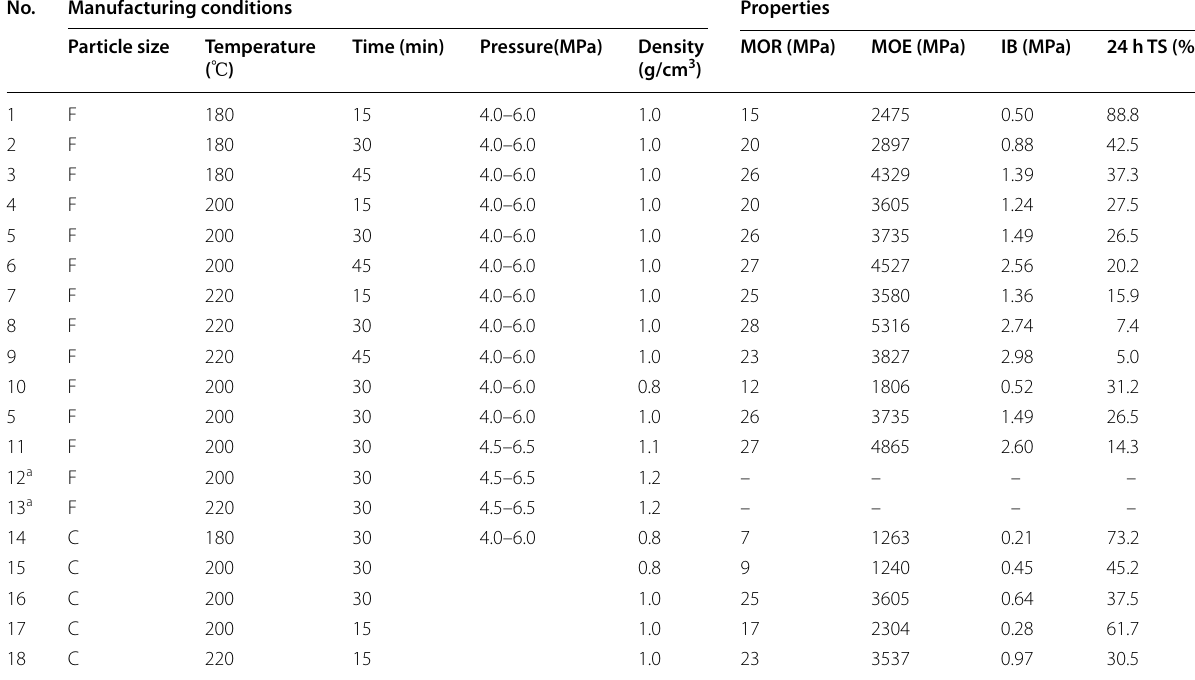
C coarse, F fine a The no.12 and no. 13 binderless boards delaminated during hot pressing, its physical and mechanical properties cannot be tested